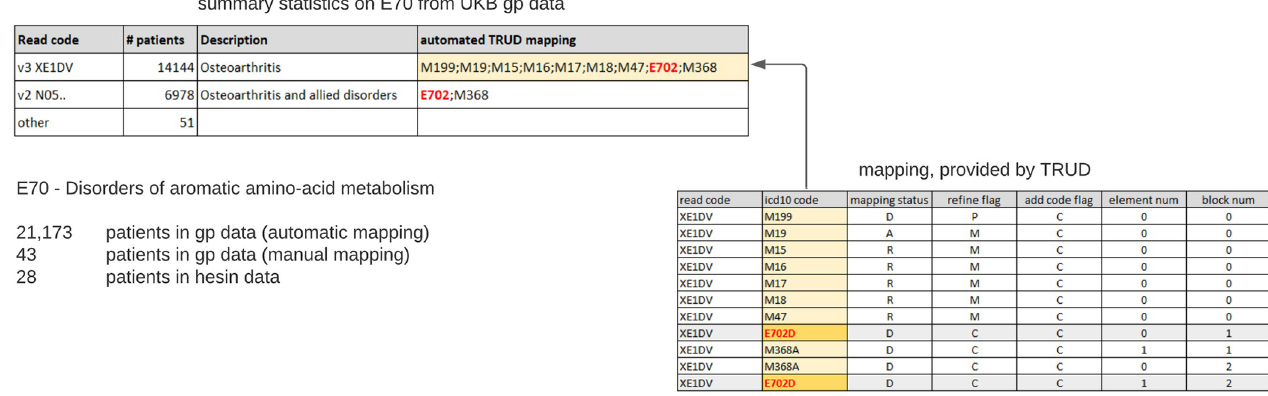
Fig 5. Automated mapping for ICD10 code E70 “Disorders of aromatic amino-acid metabolism”.